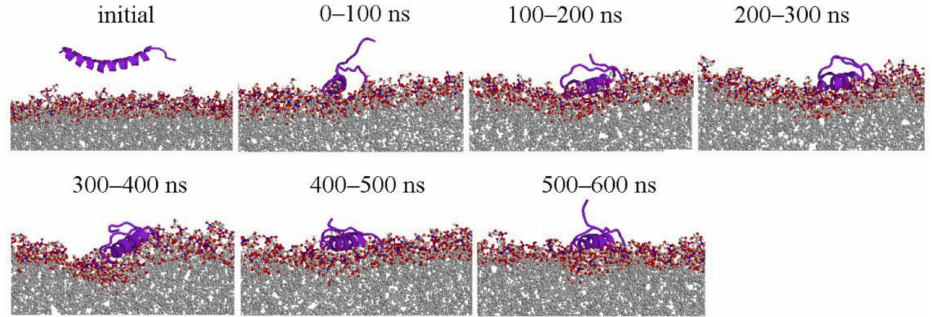
Figure 1. Representative structures of LL-37/POPG lipid (for Simulation 1). The side views of structure changes during the simulations at 100 ns intervals. Except the initial structures, each peptide structure shown at 100 ns interval is the center of clustering 100 ns conformations. Peptides, and phosphorus and oxygen atoms of lipid were colored purple, blue, and red, respectively. Peptides are displayed with cartoon models and the others were displayed with ball and stick model by RasMol tool (http://www.openrasmol.org/) [33].